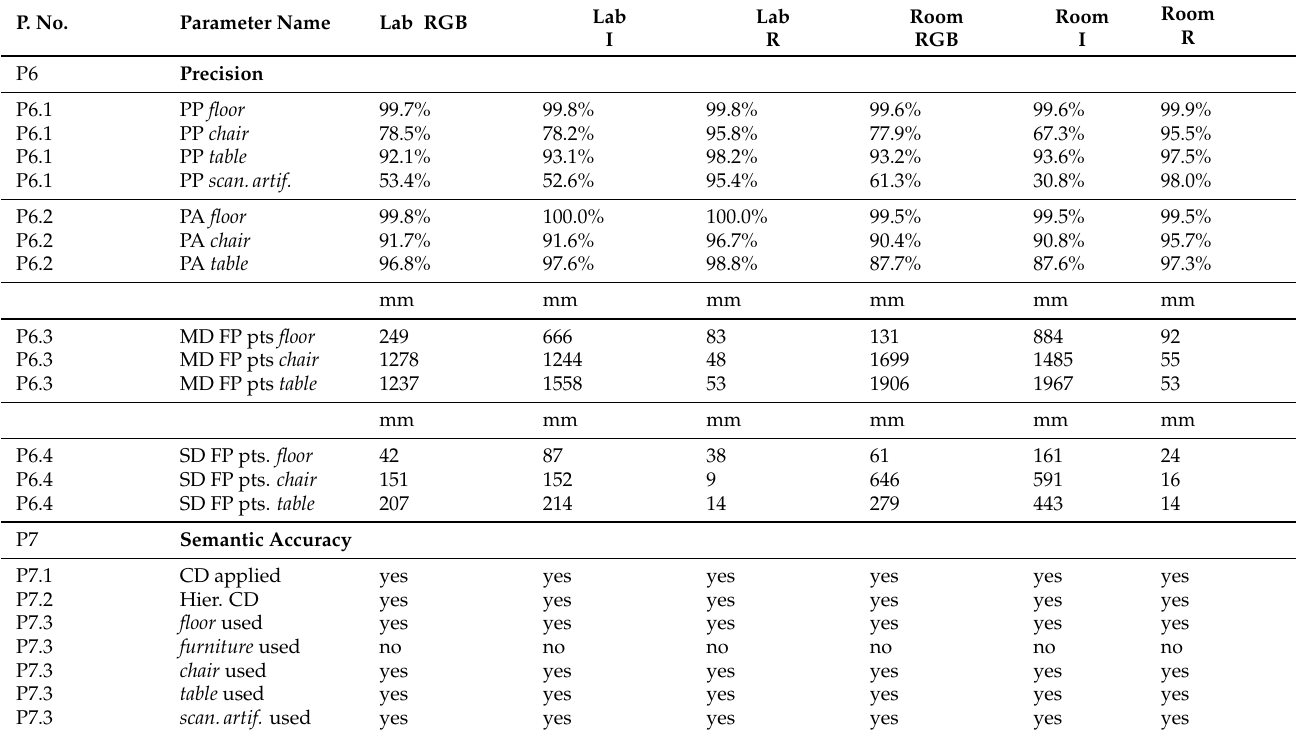
Table 14. Calculated and determined values for precision and semantic